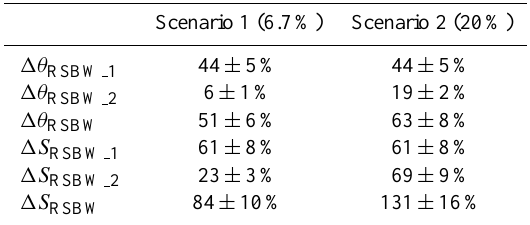
Table 4. Possible warming and freshening of the AA-AABW in- duced by change in property, decrease in volume transport of the RSBW, and their summations under the two scenarios of volume transport decrease of 6.7%/10 years and 20%/10 years. Results are shown in the form of ratio to the overall warming and freshening of the AA-AABW estimated in Sect. 2. Subscripts “1” denote contri- bution by change in property (first term in right hand side of Eq. 10) and subscript “2” denote contribution by decrease in volume trans- port of the RSBW (second term in right hand side of Eq.